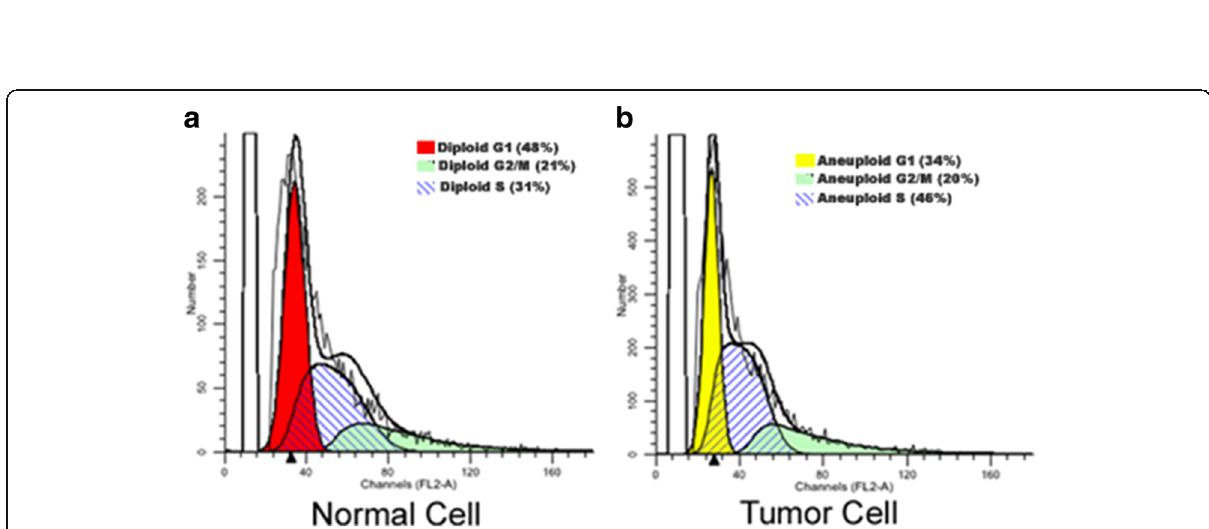
Fig. 4 Histogram of Cell cycle analysis of ( a ) adjacent control gastric cell and ( b ) Tumor gastric adenocarcinoma cell ( p value =